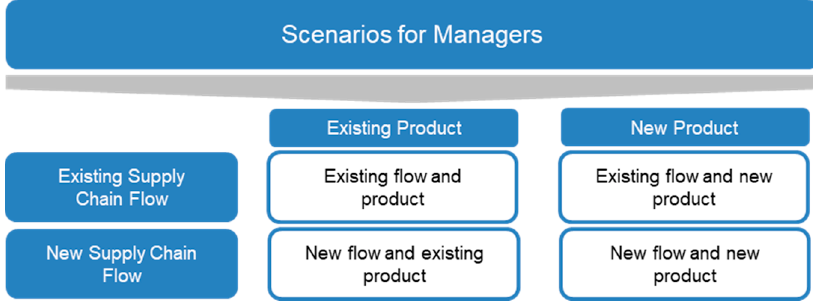
Figure 7. Discussion framework: scenarios for managers (own elaboration).